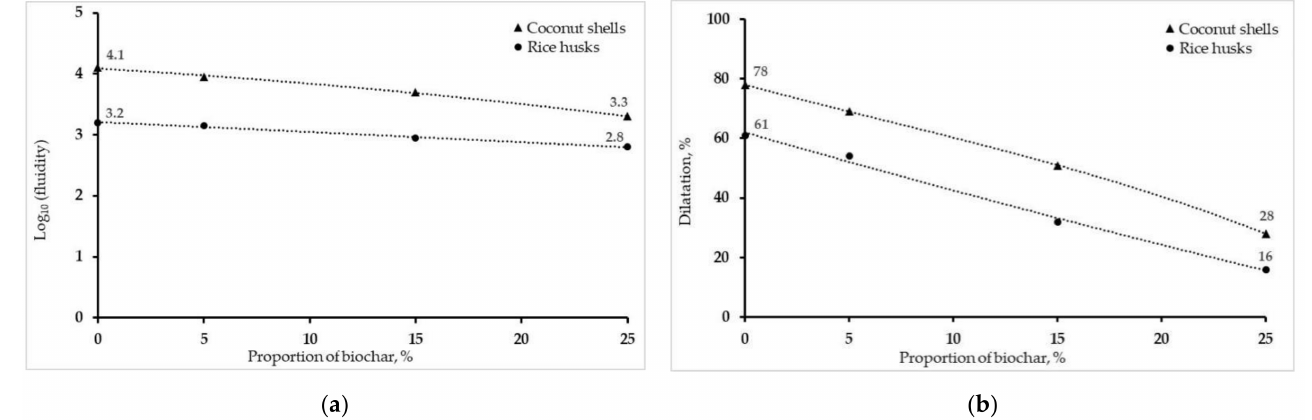
Figure 9. Thermal rheology of coal blends: ( a ) fluidity; ( b )